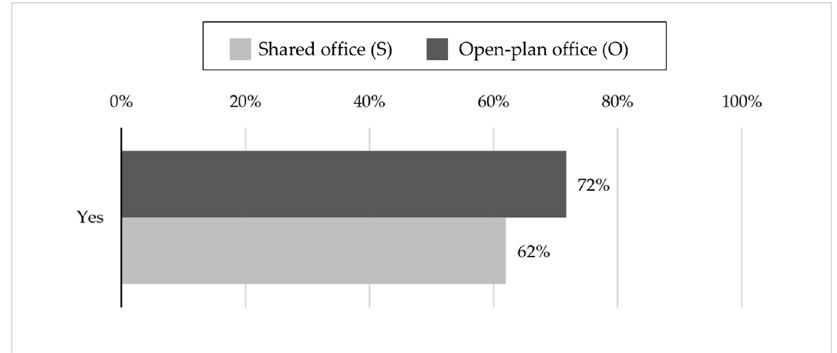
Figure 2. Percentages related to the willingness of the occupants to be influenced by a noise monitoring system with lighting feedback that encourages behavioral changes, such as the decrease of the voice volumes in order to reduce ISN.